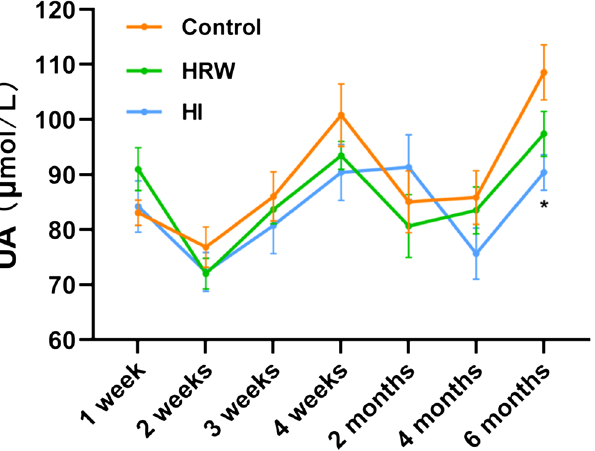
Figure 3. Effects of hydrogen treatment on serum uric acid. Values shown are mean ± SEM (n = 10). For comparison of HI and Control group, * p < 0.05. Figure was made with GraphPad Prism 8.0.2, https ://www.graph pad.com/suppo rt/faq/prism -802-relea se-notes